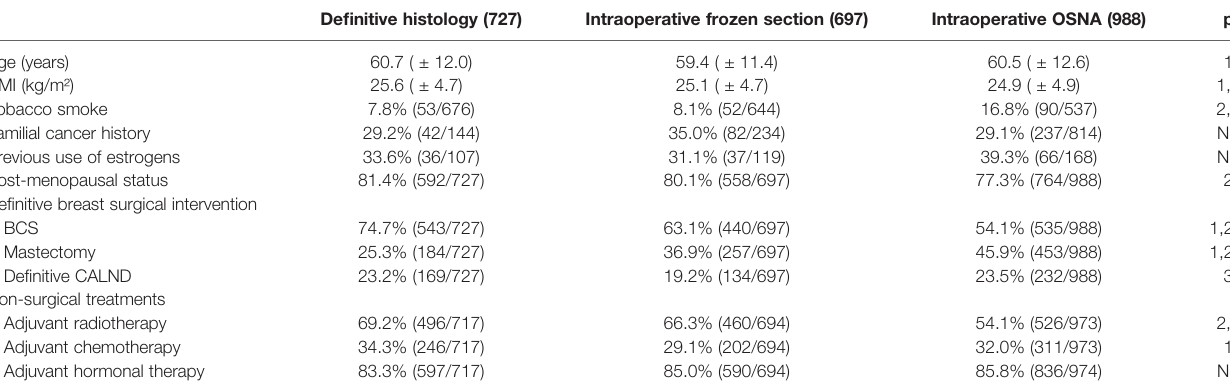
TABLE 1 | Description of the population subdivided in the three considered groups (de fi nitive histology, intraoperative frozen section, and